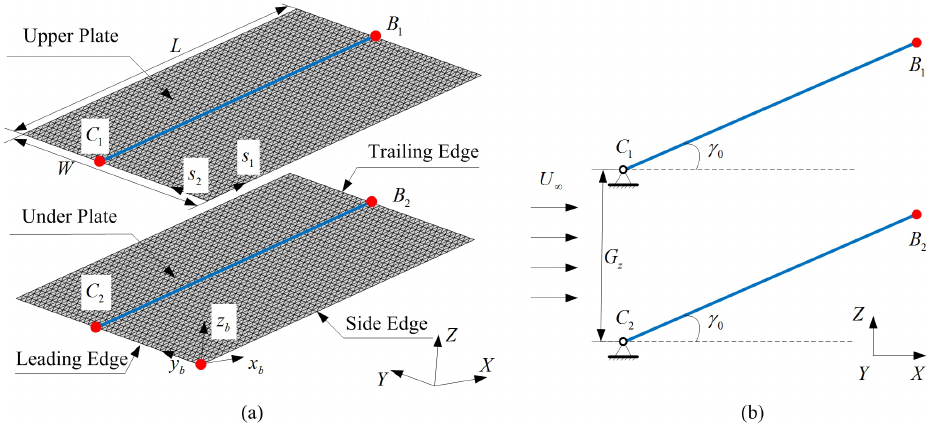
Figure 1. Schematic of the flow over two flexible plates in side-by-side arrangement: ( a ) axonometric view; ( b ) side